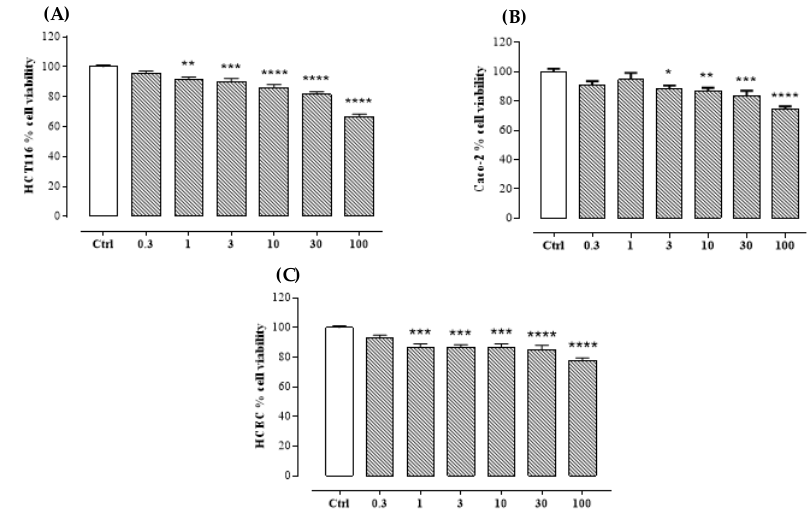
Figure 2. E ff ect of cis-bis(methylthio)silvatin (0.3–100 µ M) on cell viability, evaluated by the MTT assay, in the colorectal cancer cell lines HCT116 ( A ) and Caco-2 ( B ), and in the non-tumoral colonic epithelial cell line HCEC ( C ). Cells were incubated with an increasing concentration of the compound (24 h exposure). Each bar represents the mean ± SEM of three independent experiments. * p < 0.05, ** p < 0.01, *** p < 0.001, and **** p < 0.0001 versus control (ctrl, untreated cells).